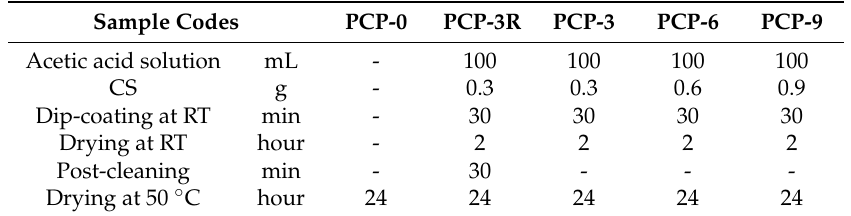
Table 1. Details of coating applications. The sample codes were also used for the corresponding single-fibre composites